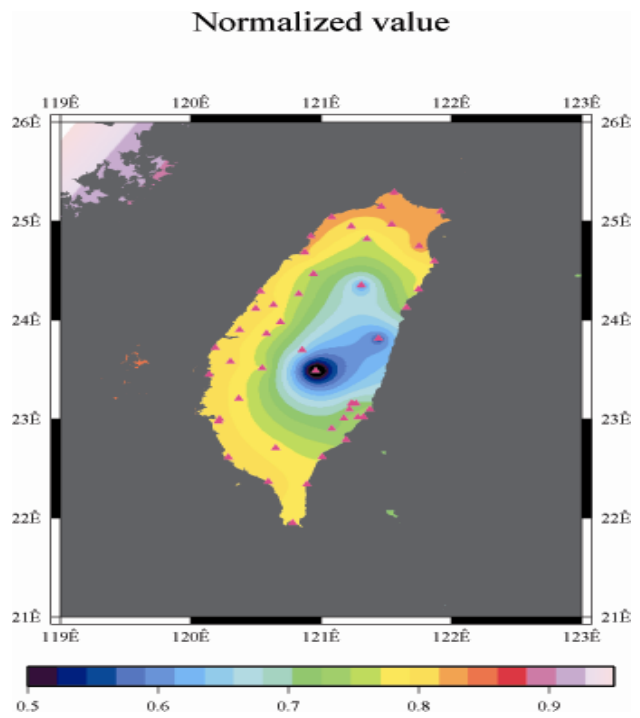
Figure 10. Normalized ZTD values when the typhoon started to strike Taiwan (September 13th, 2008, 11:00